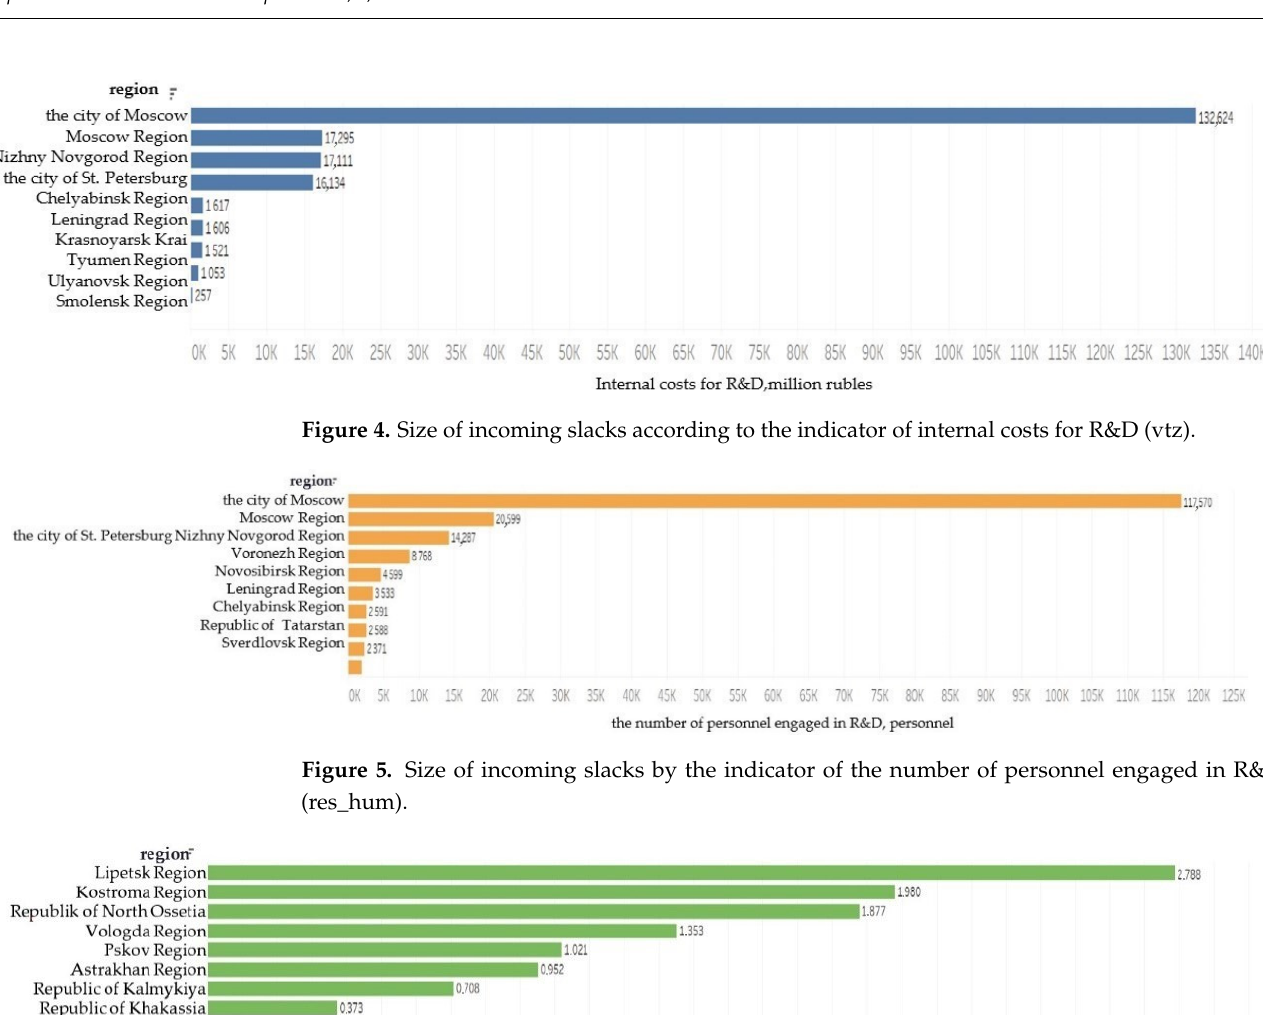
Figure 5. Size of incoming slacks by the indicator of the number of personnel engaged in R&D (res_hum).